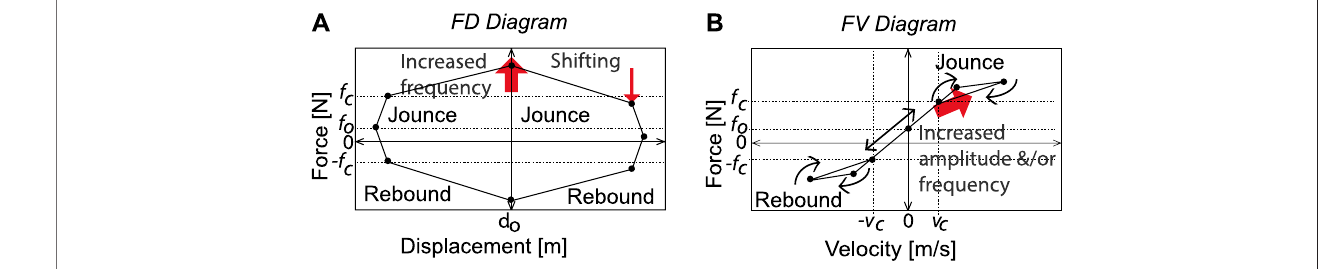
FIGURE 6 | Characteristic diagrams at ω M , Type-2 .